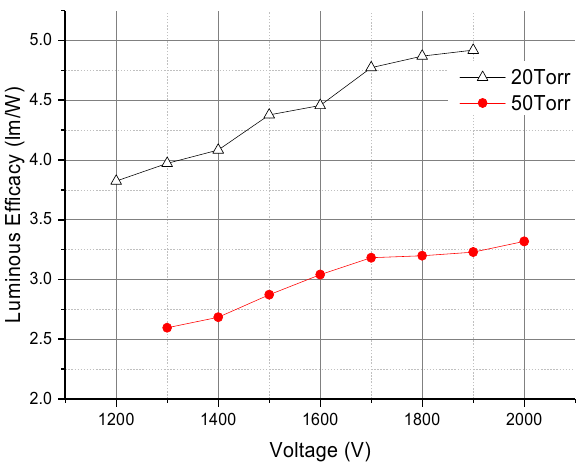
Figure 8. Luminous efficacy versus voltage at different pressures.